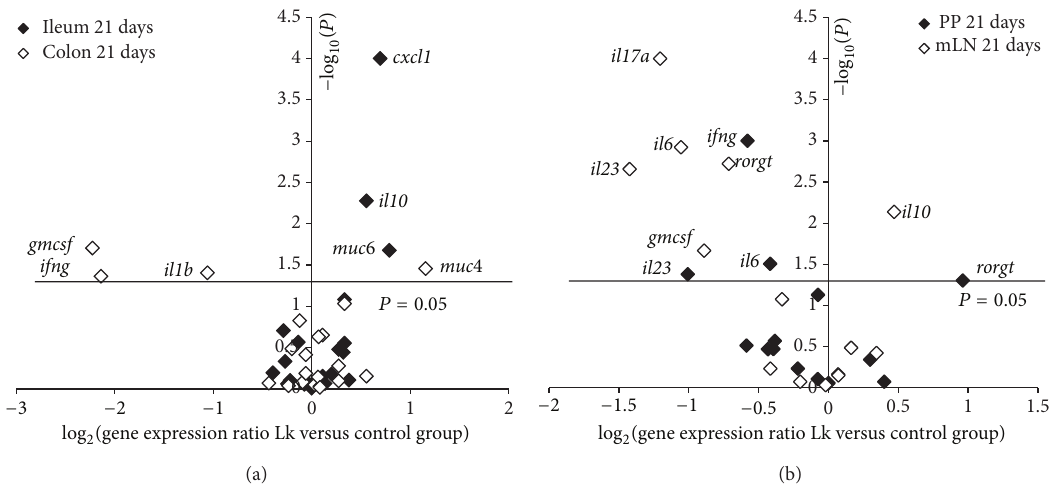
Figure 4: Gene expression ratio of Lk group versus control group after 21 days of L. kefiri administration. The x -axis of the plot represents log 2 relative expression level of the gene and the x -axis displays the − log 10 P (statistical significance). The names of the genes which displayed significant differences are included. (a) Expression in ileum (black) and colon (white). (b) Expression in PP (black) and mLN (white).